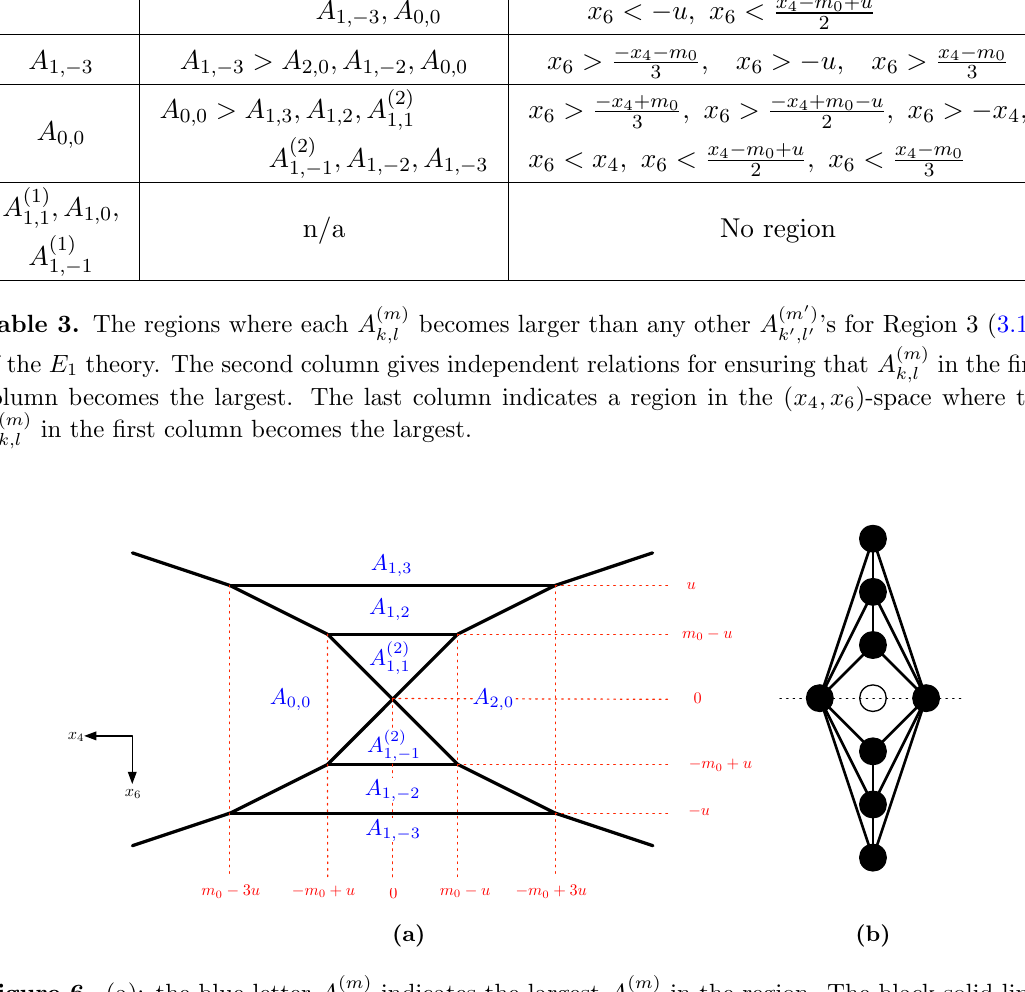
Figure 6. (a): the blue letter A ( m ) indicates the largest A ( m ) in the region. The black solid lines k;l k;l are the boundaries of those regions and give the 5-brane web in the decompacti(cid:12)cation limit of the E 1 curve in Region 3 (3.12). (b): the toric-like diagram of the E 1 theory with a triangulation given by the web in (cid:12)gure